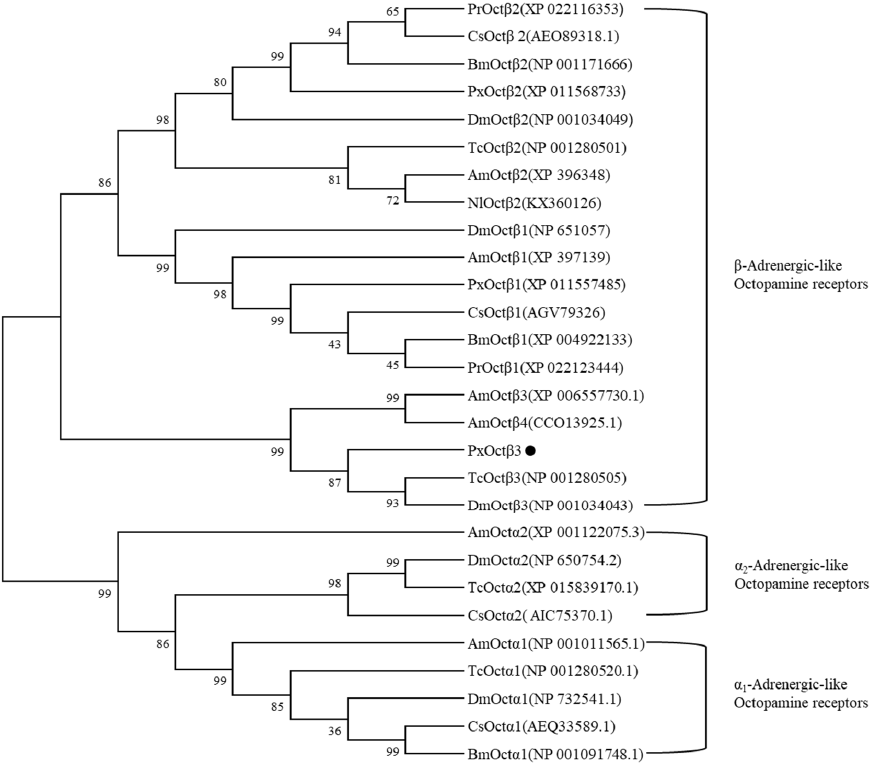
Figure 2. Phylogenetic tree analysis of representative members of the different OARs. Phylogenetic reconstruction was performed using the amino acid positions that were found in the TM1 to 7 regions. Numbers in the middle of the branches denote percentage bootstrap support with 1000 replications per branch. The receptor names followed by their GenBank accession numbers are listed in the tree. Bm, Bombyx mori ; Pr, Pieris rapae ; Cs, Chillo suppressalis ; Px, Plutella xylostella ; Dm, Drosophila melanogaster